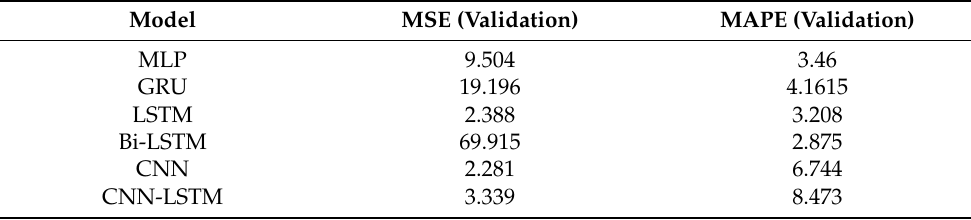
Table 10. The validation results of the models using Apple data with four input